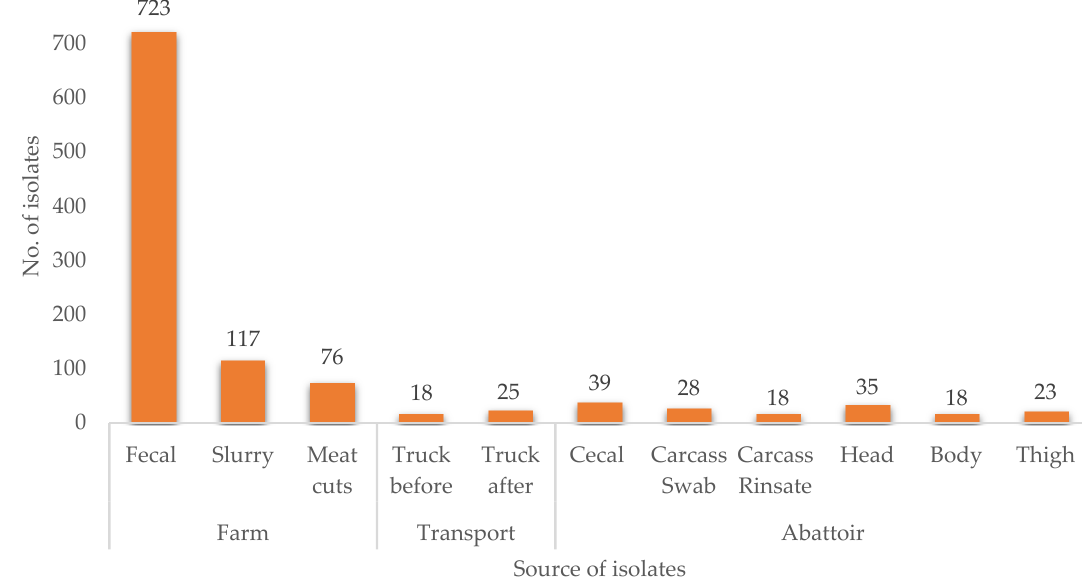
Figure 1. Distribution of Escherichia coli isolates along the pig production system, according to source and site.